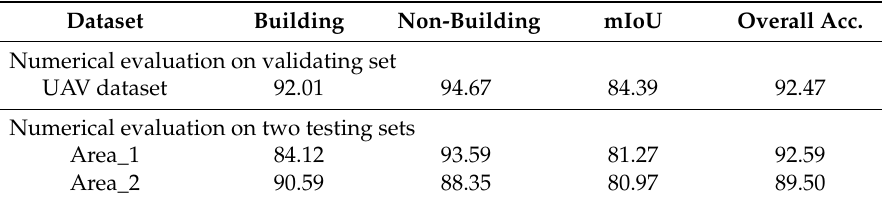
Table 3. Classification accuracy results of UAV dataset (%).